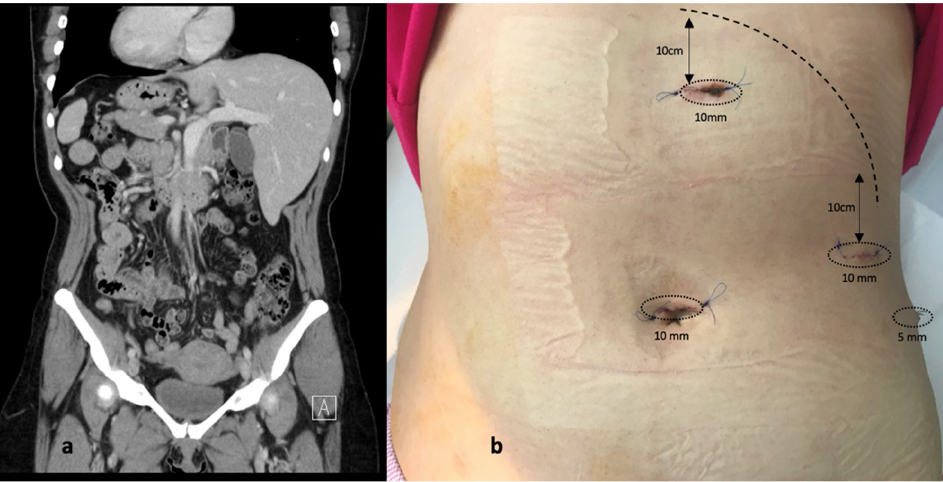
Figure 2. ( a ) Abdominal CT scan demonstrating situs inversus totalis ( b ) Disposition of ports (post- operative